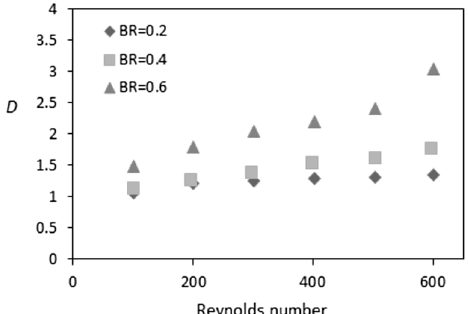
Fig. 5 Validation of the results related to friction coefficient obtained for present work with that Bergman and Incropera [25]